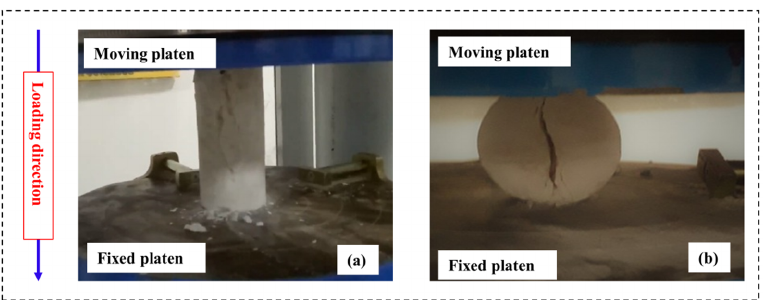
Figure 2. ( a ) Deformed rock core specimen for Brazilian tensile strength test and ( b ) deformed rock core specimen for UCS test. Figure 3 represents histogram plots of the original dataset in this study: (a) dry den- sity (g/cm 3 ), (b) BTS (MPa), (c) wet density (g/cm 3 ), and (d) UCS (MPa). Figure 4 presents